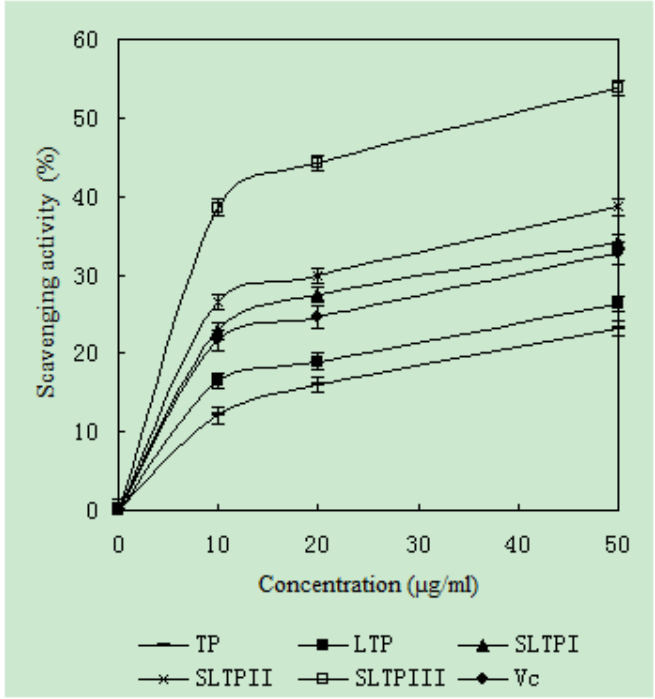
Figure 2. Scavenging activity of natural TP, its derivatives and Vitamin C against DPPH radicals. Values were means ± SD (n =